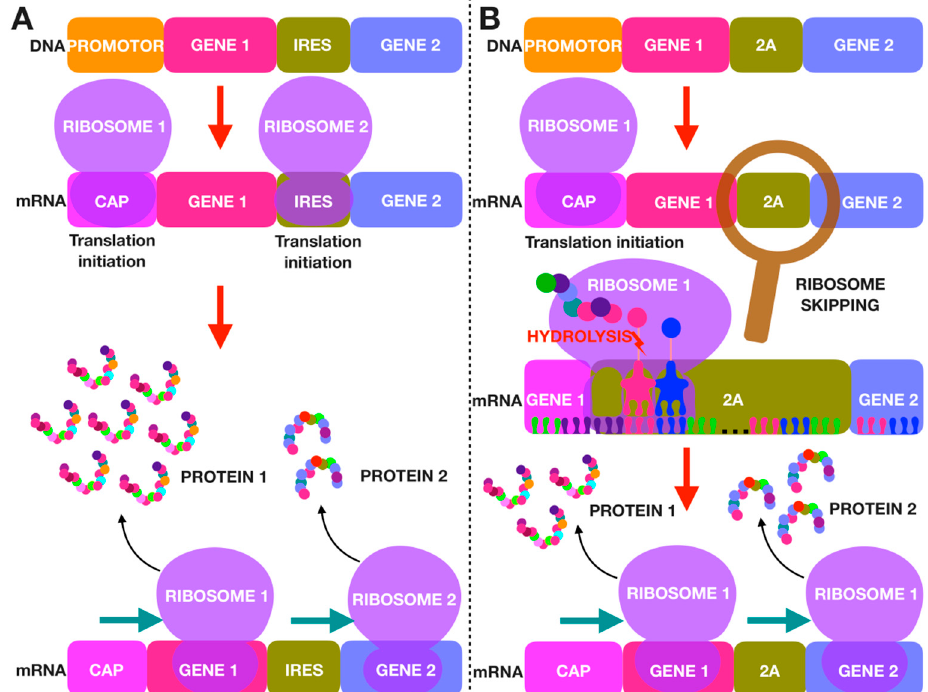
Figure 1. Comparison of the translation mechanism in internal ribosome entry site (IRES)-based and 2A